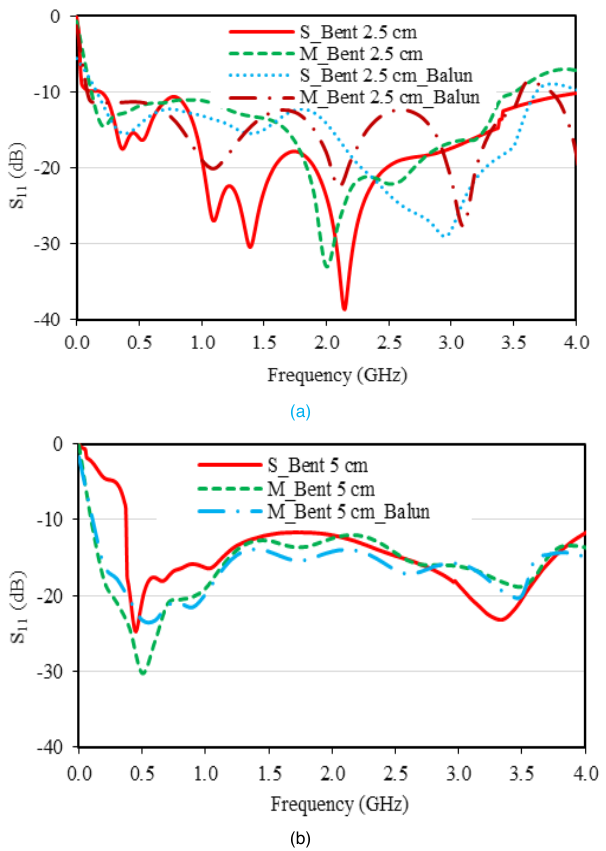
FIGURE 6. Simulated radiation patterns of (a) flat and (b) bent flexible antenna with and without Balun in phantom (2.5 implantation depth) at resonance frequencies in f =0° H-plane (left) and f =90° E-plane